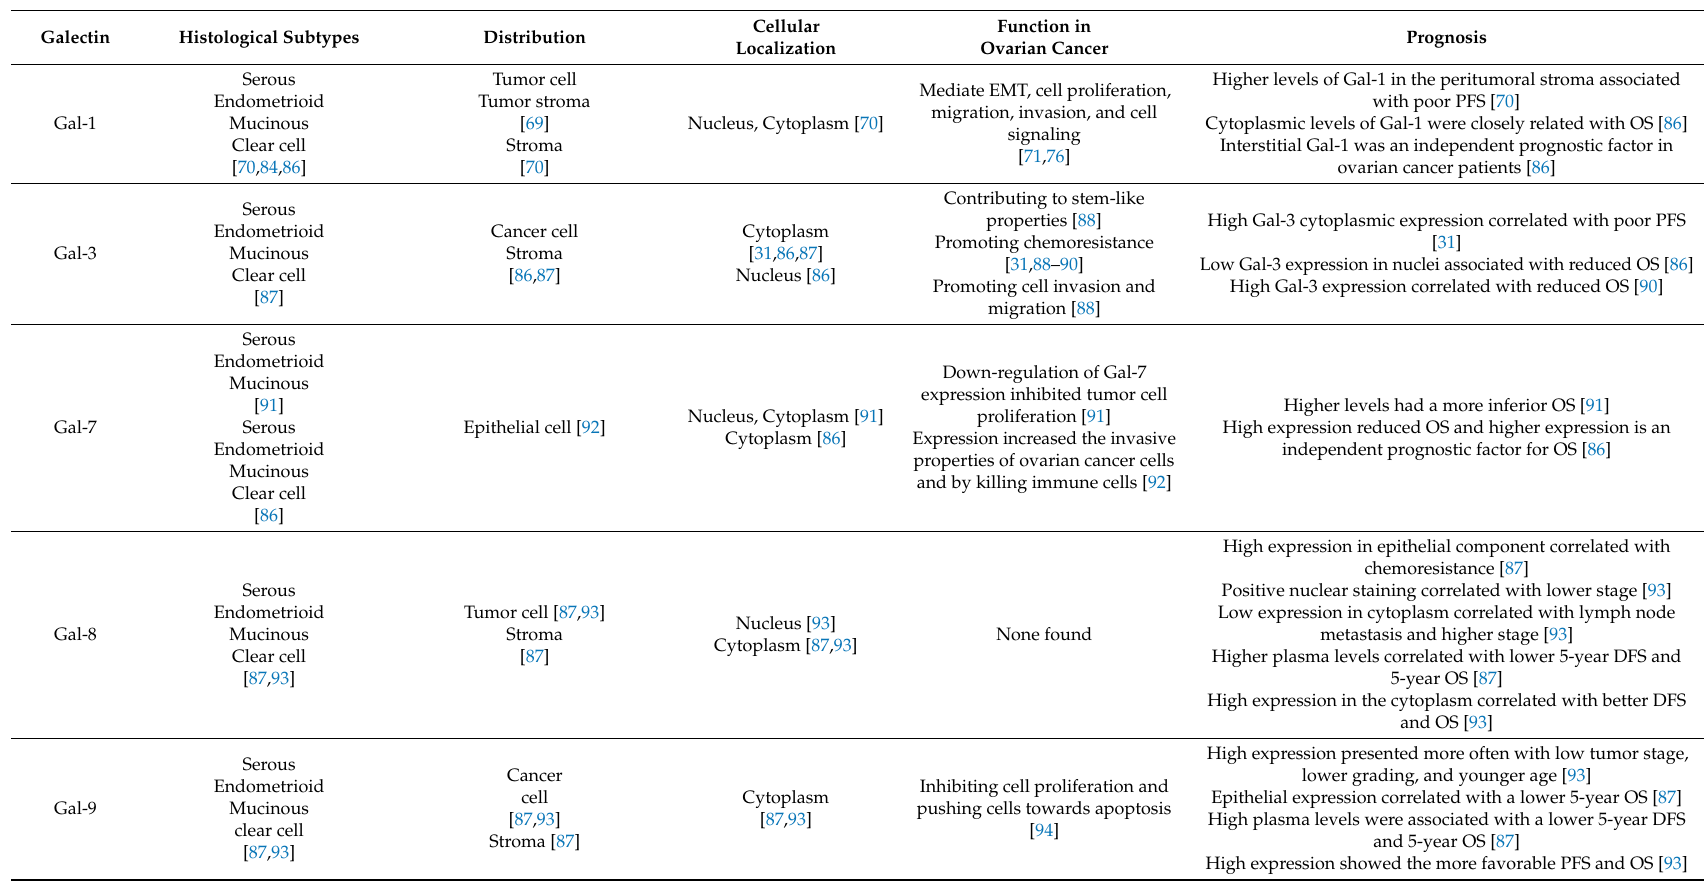
Table 1. Expression, localization, cellular distribution, proposed function, and biomarker relevance for galectins in ovarian